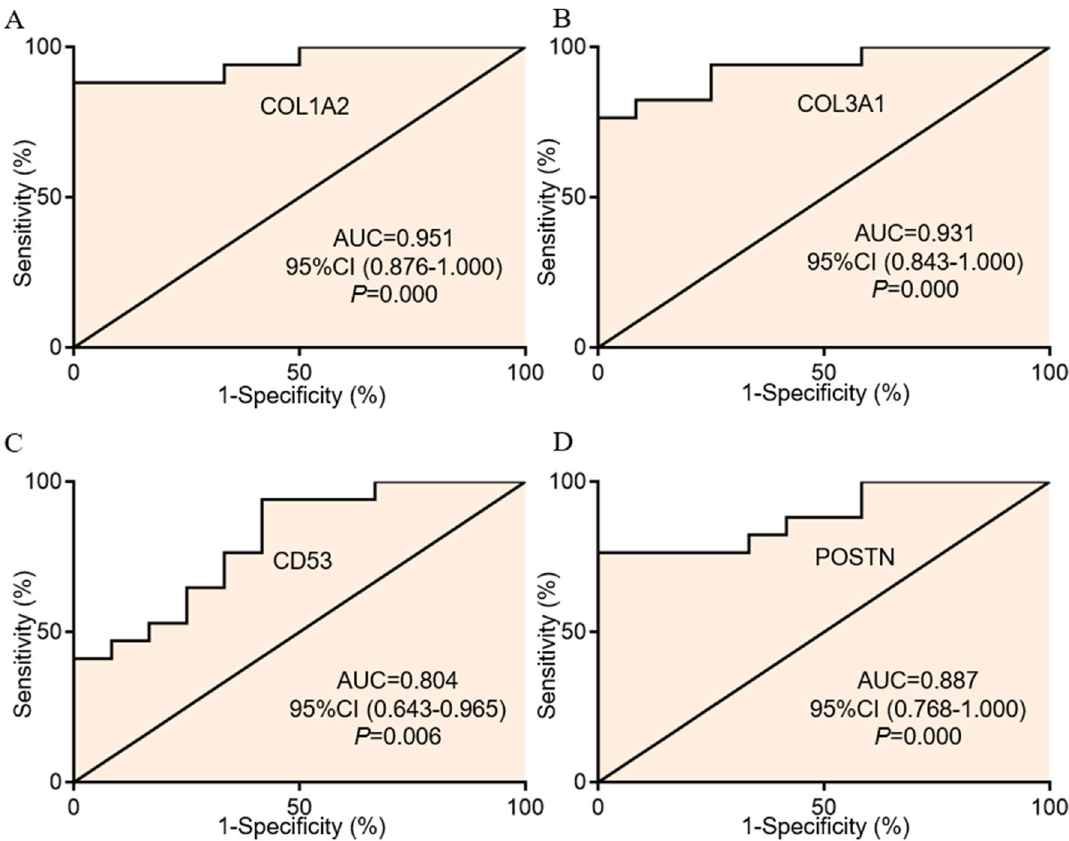
Figure 8. The diagnosis value for potential immune-related genes in DCM. ( A ) The ROC curves of COL1A2 , ( B ) The ROC curves of COL3A1 , ( C ) The ROC curves of CD53 , and ( D ) The ROC curves of POSTN . DCM: dilated cardiomyopathy; ROC: receiver operating